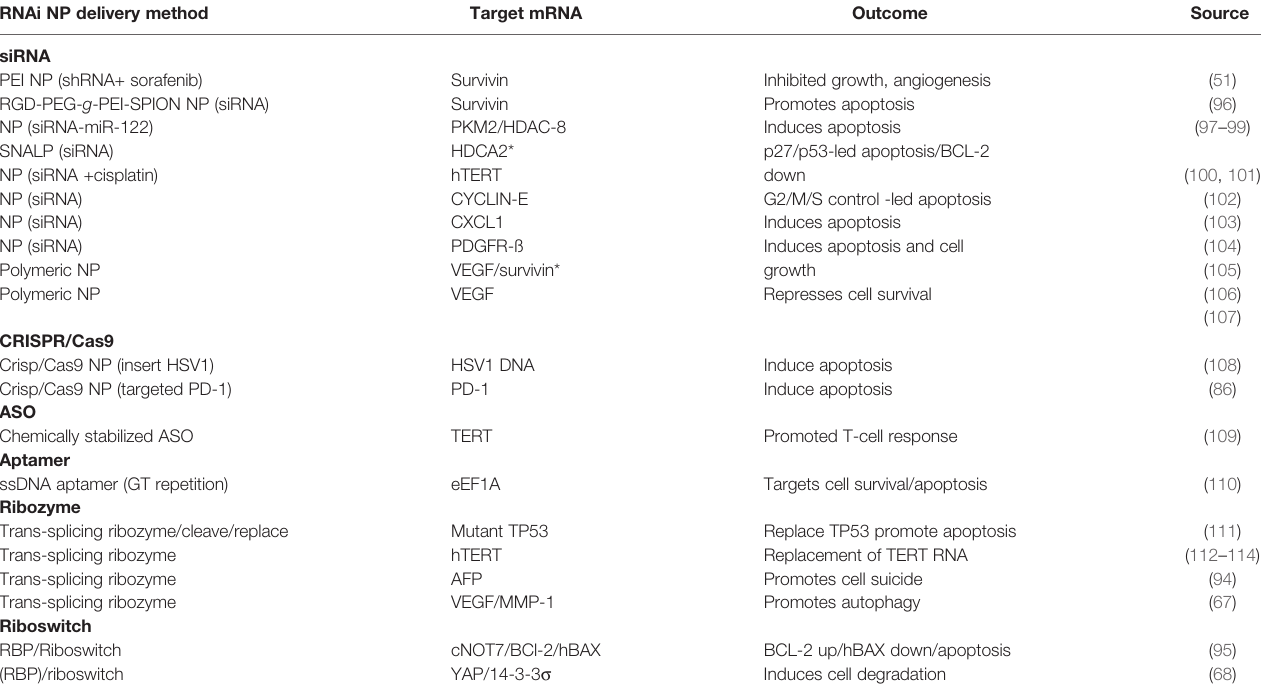
TABLE 3 | RNAi pro-apoptotic therapeutics.